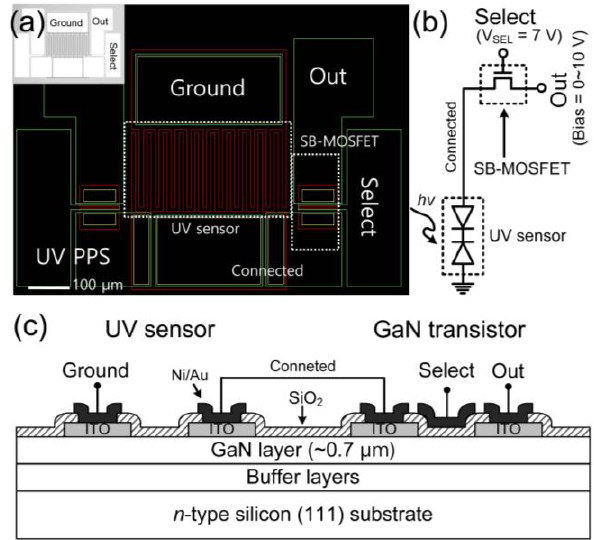
Figure 1. ( a ) Mask layout with pad names (inset: micro-photograph image of fabricated device), ( b ) schematic circuit diagram, and ( c ) cross-sectional view of proposed GaN ultraviolet (UV) passive pixel sensor (PPS) structure.